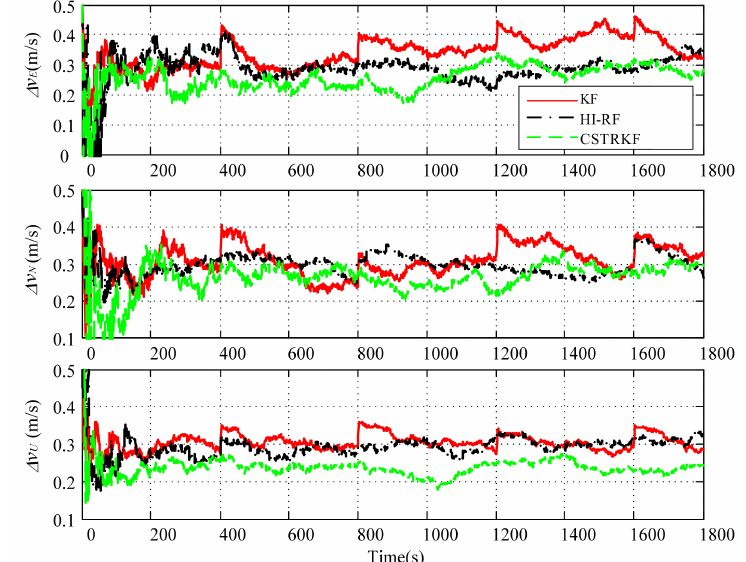
Figure 4. Velocity error of the INS / SRS / CNS integrated system with di ff erent filters under the condition of measurements with outliers.